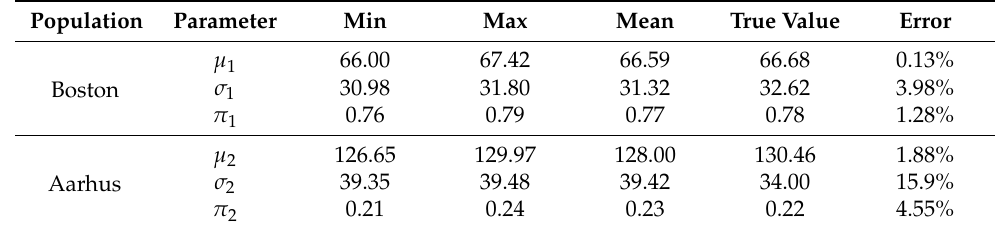
Table 2. Summary of the parameter estimation for random variance.